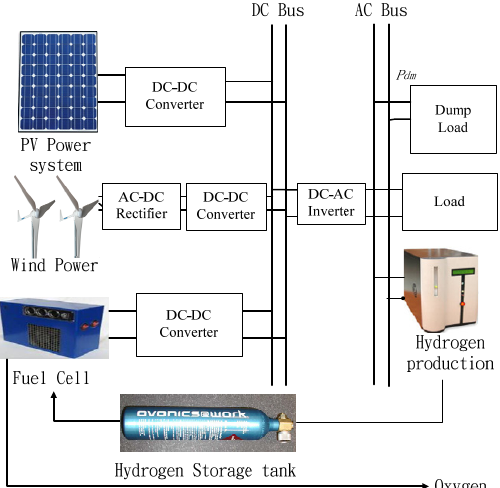
Figure 1. System architecture.